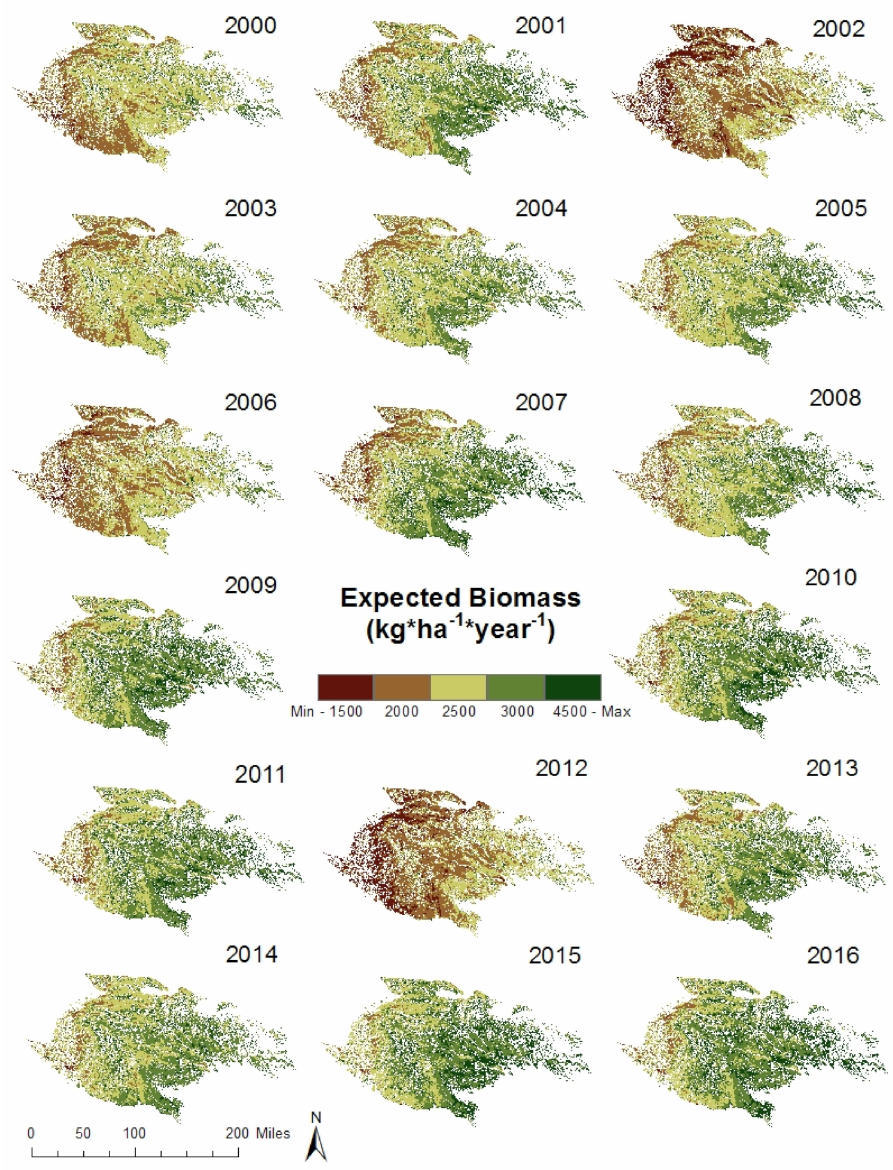
Figure 4. EB maps for the study period (2000–2016) in the Sandhills MLRA that were masked to include only desired grassland